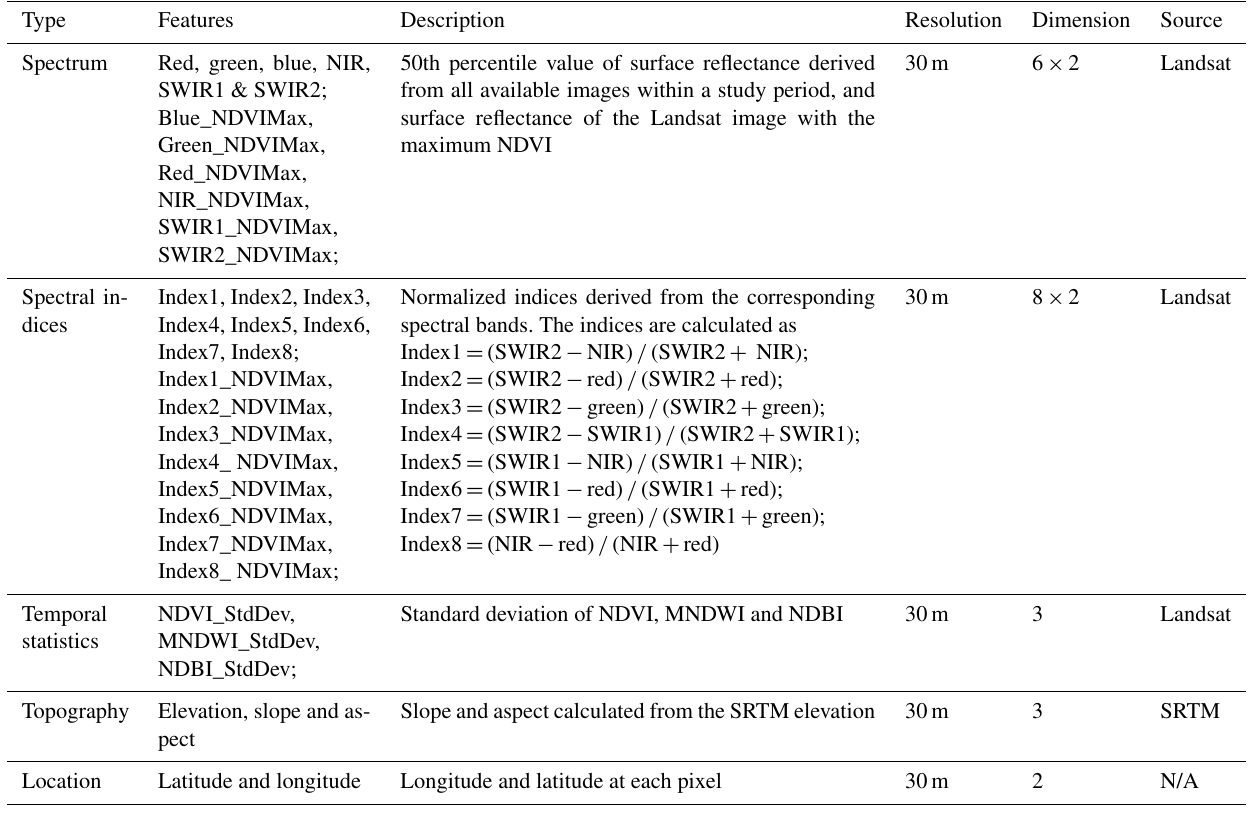
Table 1. The explanatory table of features used for CLCD mapping ∗ .